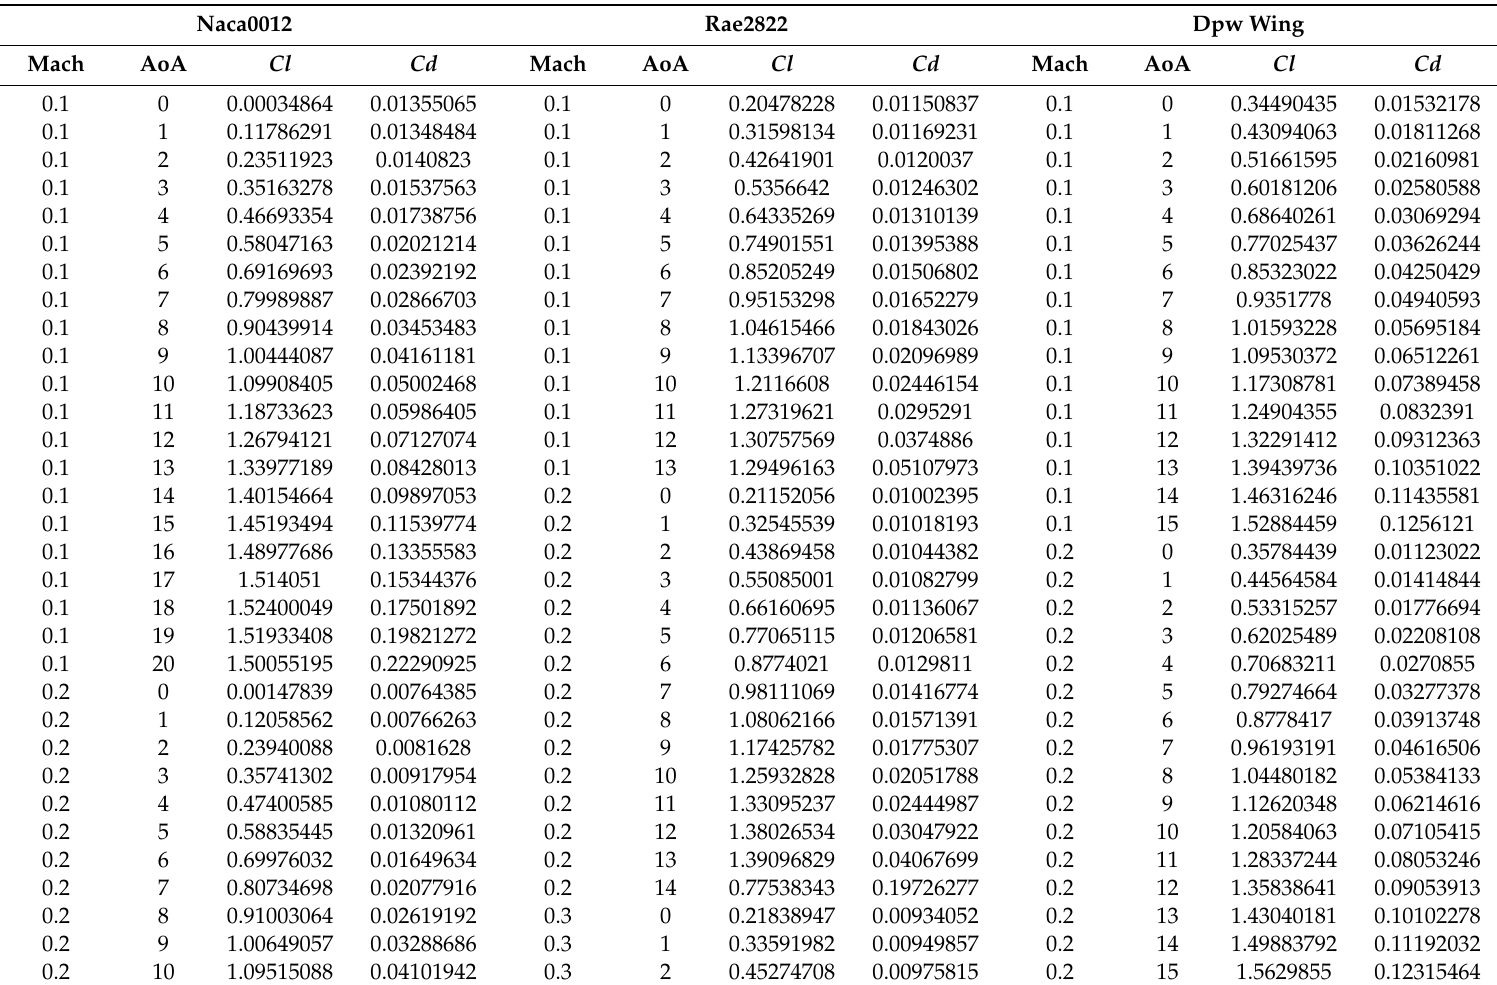
Table A1. Aerodynamic databases for naca0012, rae2822 and dpw test